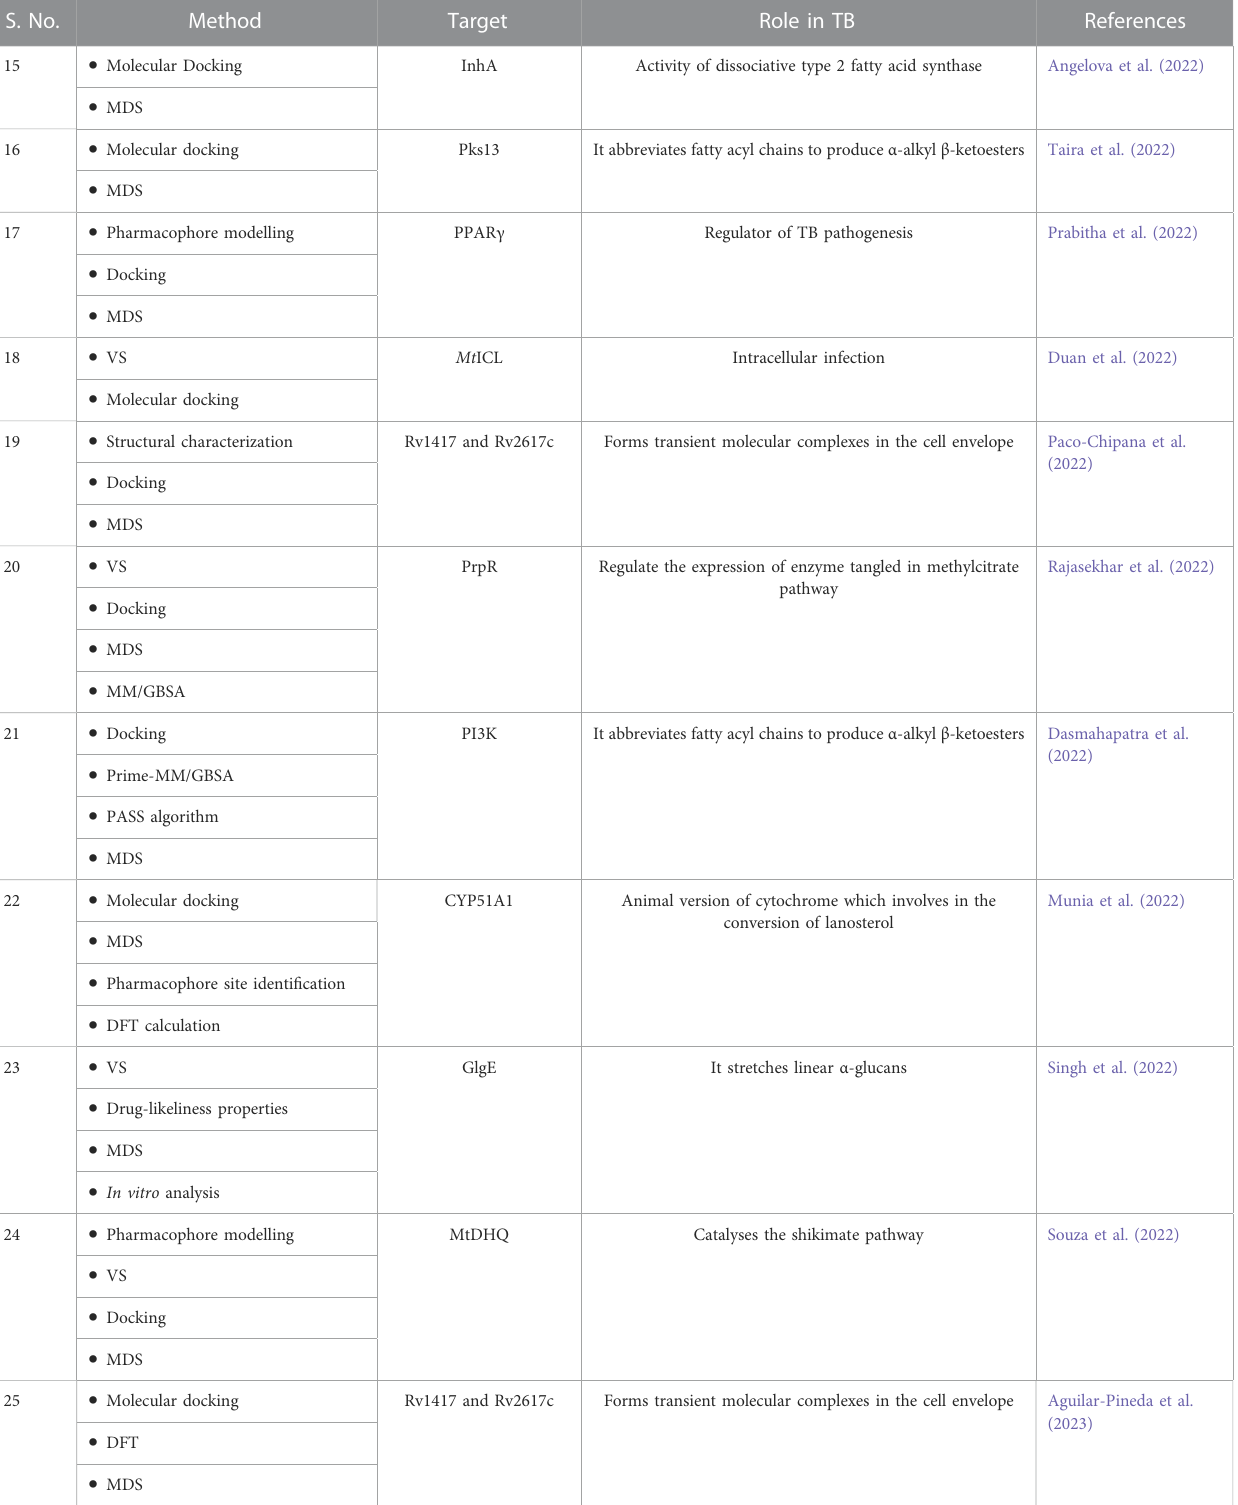
TABLE 4 ( Continued ) List of methods for Structure based drug designing (SBDD) against TB. S.